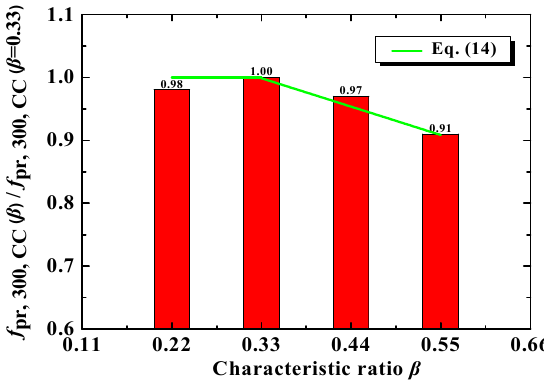
Figure 15. Variation of combined compressive strength of prisms with characteristic ratio.